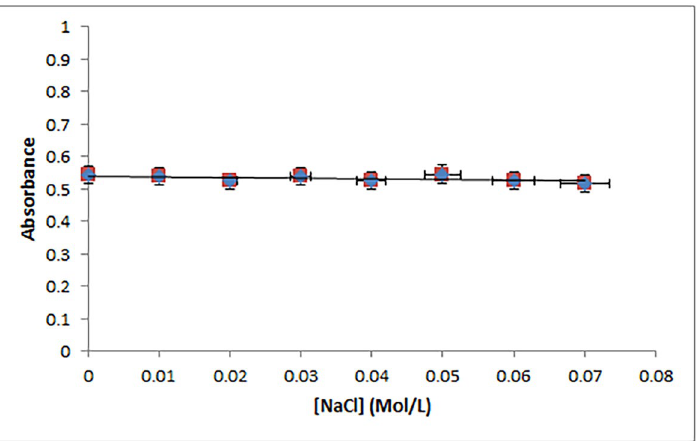
Figure 5. Influence of the ionic strength of NaCl on the absorbance of CT-DNA-PLB complex. Concentrations of PLB and CT-DNA were 2.0 × 10 −5 M and 8.25 × 10 −5 M, respectively. The concentrations of NaCl: 0, 0.01, 0.02, 0.03, 0.04, 0.05, 0.06, 0.07 M.